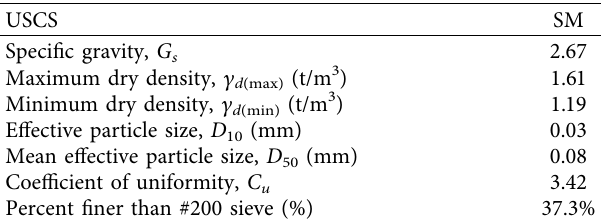
Table 3: Index properties of Saemangeum silty sand. USCS